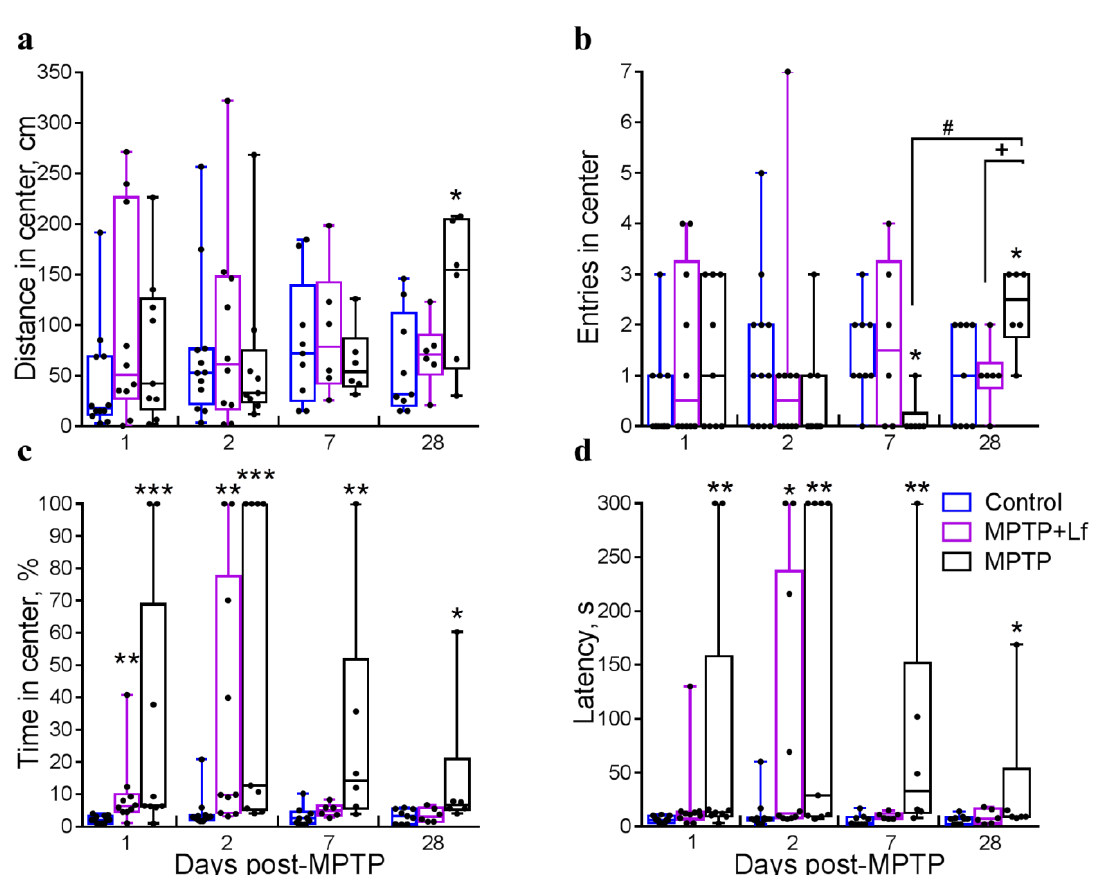
Figure 5. Behavior of mice in the center of the open field test ( a – d ) after MPTP/saline administration. Distance traveled in the center of the field ( a ). Number of entries into the central area ( b ). Percent time spent in center ( c ). Latency to exit from the central area ( d ). Each dot represents a single animal. n = 9–12 (days 1, 2), n = 6–9 (days 7, 28) for each group. * p < 0.05, ** p < 0.01, *** p < 0.001 compared to the Control group (saline-treated); + p < 0.05 compared to the MPTP + Lf group at each time point (Kruskal–Wallis ANOVA followed by post hoc Dunn's multiple comparisons test); # p < 0.05 compared to the same group at the previous time point (Wilcoxon matched pairs test).